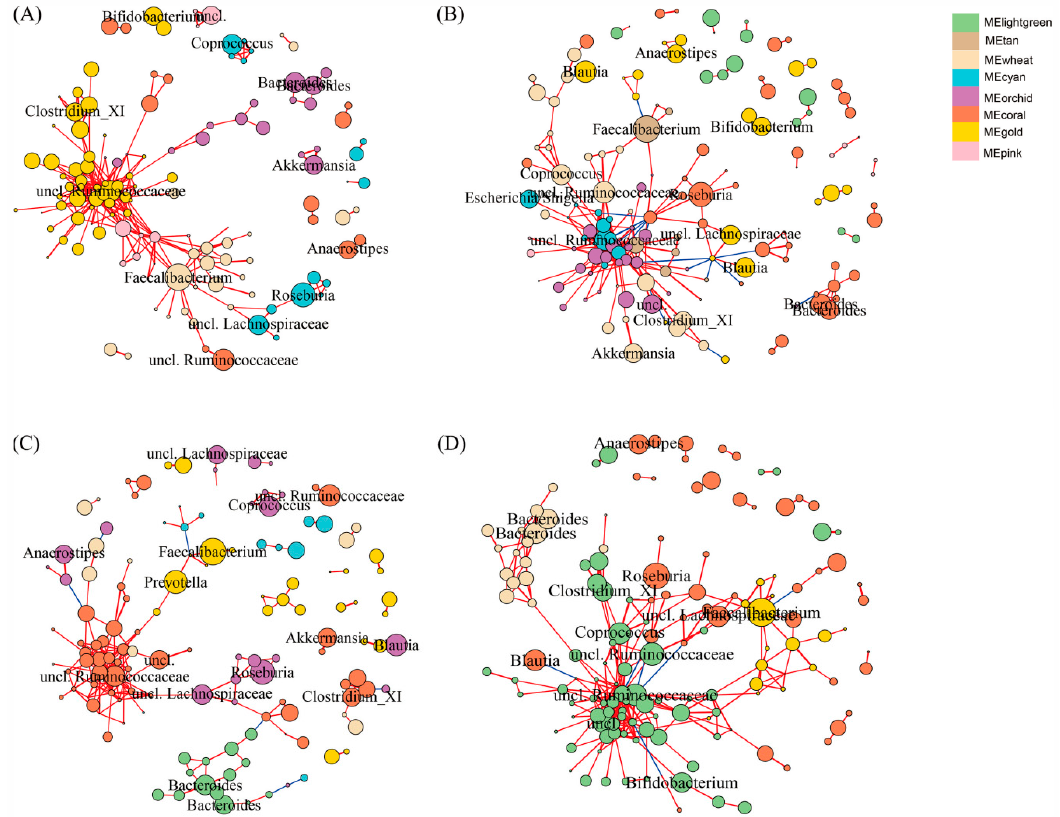
Figure 4. OTU co-occurrence network according to metabolic health phenotype. MHNO ( A ), MUNO ( B ), MHO ( C ) and MUO ( D ). OTUs (nodes) are colored according to WGCNA module colors. Positive correlations are marked by blue edges correspond and negative correlations are marked by red edges. Edges width and length are scaled to the correlation coefficient. Any resulting correlations with p value ≥ 0.05 and abs(r) < 0.6 were removed. Circle size indicates the normalized relative abundance of OTU, and the OTUs with relative abundance > 1% are marked at genus level.